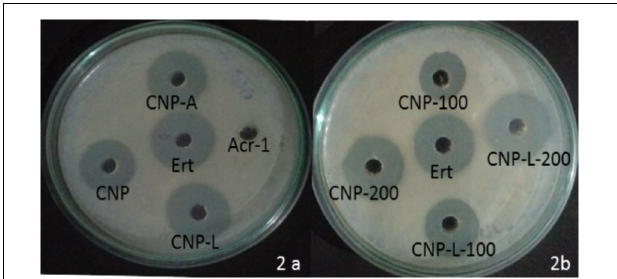
FIGURE 2 | Dose-dependent killing of M. smegmatis by various as-synthesized CNPs. (A) Antibacterial activity of various CNPs-based formulation was assessed by agar diffusion method: various CNPs (CNP, CNP-A, and CNP-L) were loaded at 100 µ g/20 µ L dose into wells of the plate exposed to M. smegmatis . Growth inhibition was determined by measuring the zone of inhibition formed in bacterial lawn after 48 h; erythromycin was used as a control. (B) M. smegmatis culture was incubated with increasing concentrations of both CNP and CNP-L group to study dose-dependent killing efficiency of as-synthesized